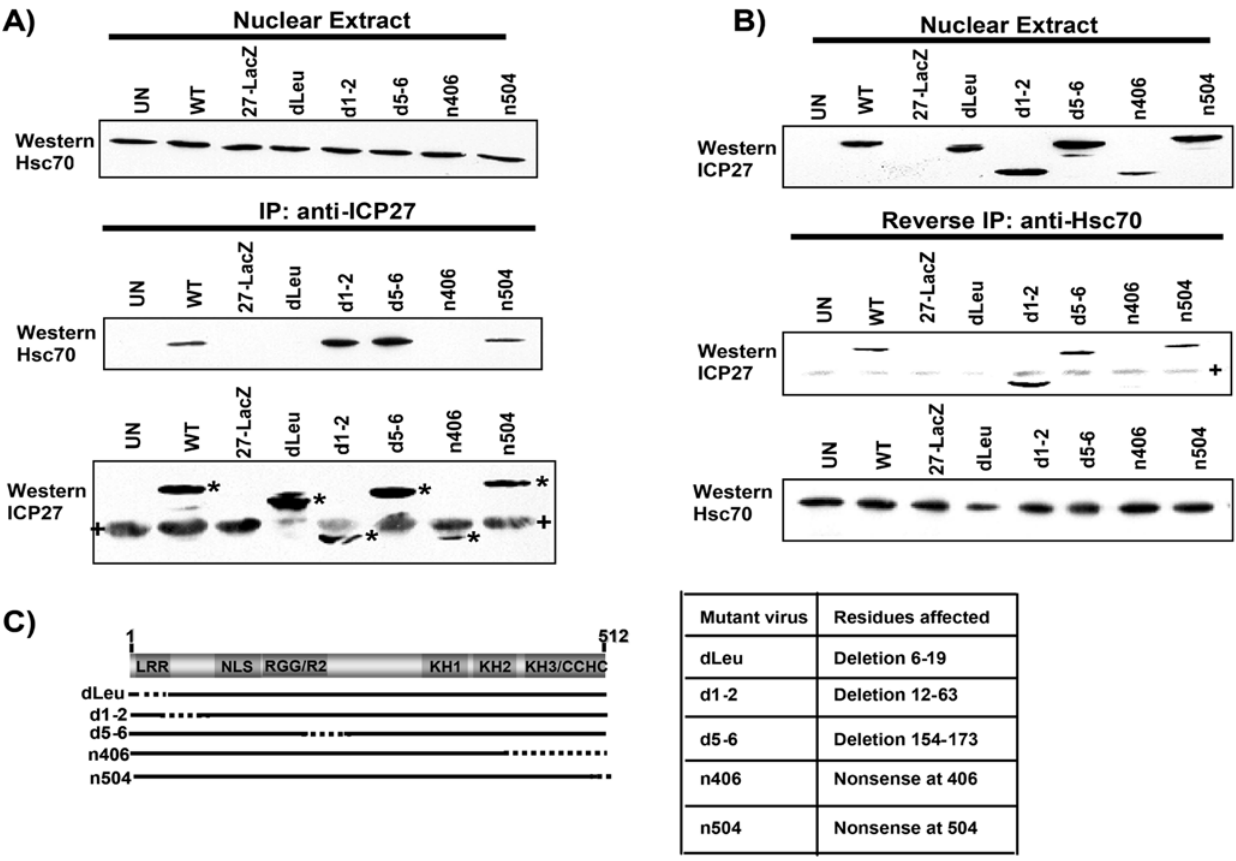
Figure 3. The N- and C-termini of ICP27 Are Required for Interaction with Hsc70 during Infection. A) HeLa cells were either mock-infected or infected with WT HSV-1 or ICP27 mutants as indicated. At 6 h after infection, nuclear extracts were prepared. Expression of endogenous Hsc70 in mock-infected cells and HSV-1 WT- and mutant-infected cells is shown by Western blot analysis of samples from nuclear extracts in the top panel. Immunoprecipitations with anti-ICP27 antibody followed by Western blot analysis with anti-Hsc70 antibody are shown in the middle panel. The bottom panel shows a Western blot of anti-ICP27 immunoprecipitated samples probed with anti-ICP27 antibody to show ICP27 expression. Asterisks (*) mark WT and mutant ICP27 protein bands. The + signs mark heavy chain IgG from the immunoprecipitations. B) Reverse immunoprecipitations were performed on samples from the nuclear extracts described above. The top panel shows the expression of WT and mutant ICP27 in the nuclear extracts. Immunoprecipitation of each sample was performed with anti-Hsc70 antibody and Western blot analysis was performed by probing with anti-ICP27 antibody, as shown in the middle panel. The + sign marks heavy chain IgG from the immunoprecipitation. The bottom panel shows a Western blot of anti-Hsc70 immunoprecipitated samples probed with anti-Hsc70 antibody. C) A schematic diagram of the ICP27 coding region is shown in the left panel with the positions of the deletions illustrated by dotted lines. The table in the right panel describes the residues deleted or mutated in each mutant